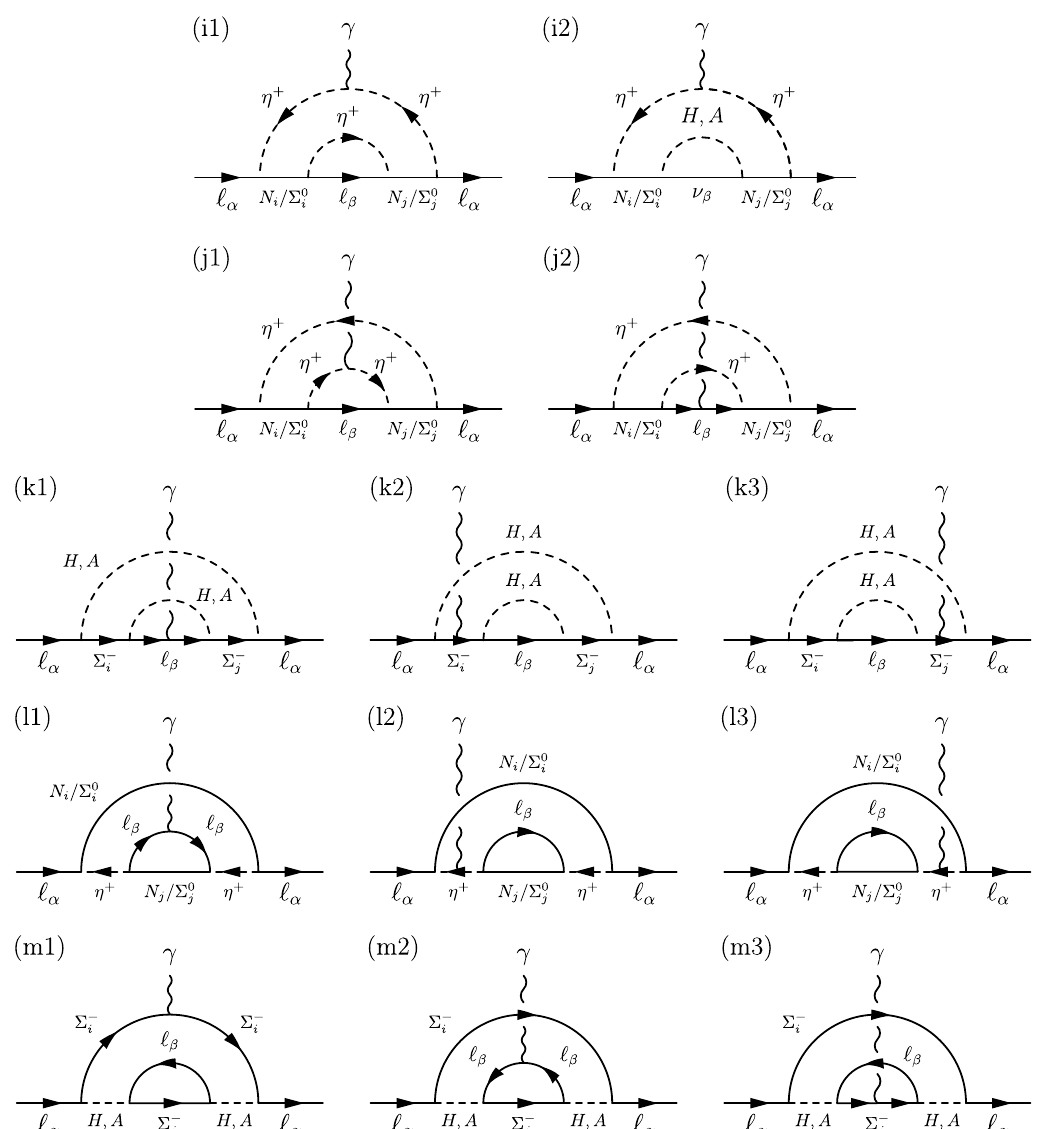
Figure 5 . Dirac type diagrams not contributing to charged lepton